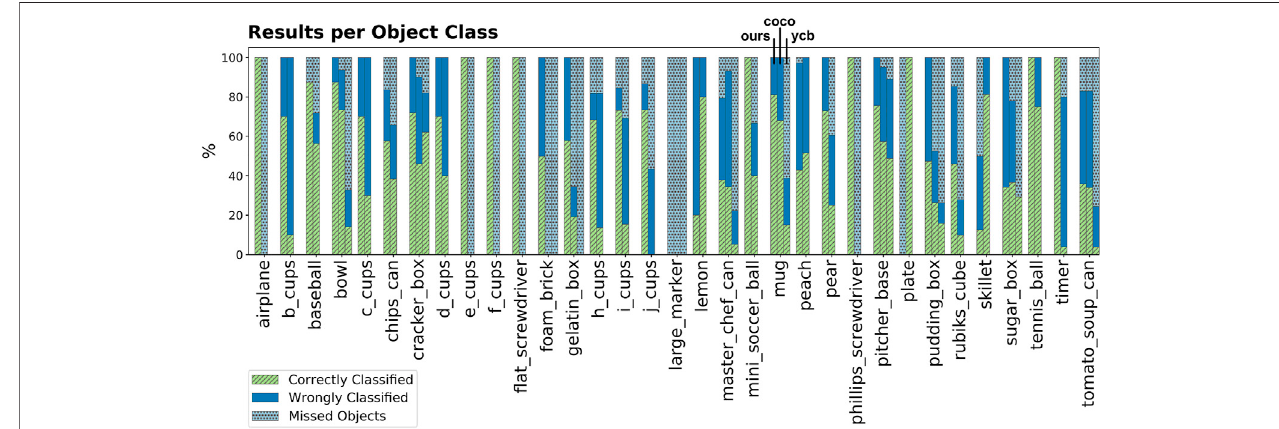
FIGURE 5 | Overview ofYCB objects used in the dataset. The performance for each object is shown for our approach ( fi rst bar), COCO-baseline (second bar) and YCBV-baseline (third bar). If the object is not in the YCBV dataset, no bar for YCBV-baseline is visualized.